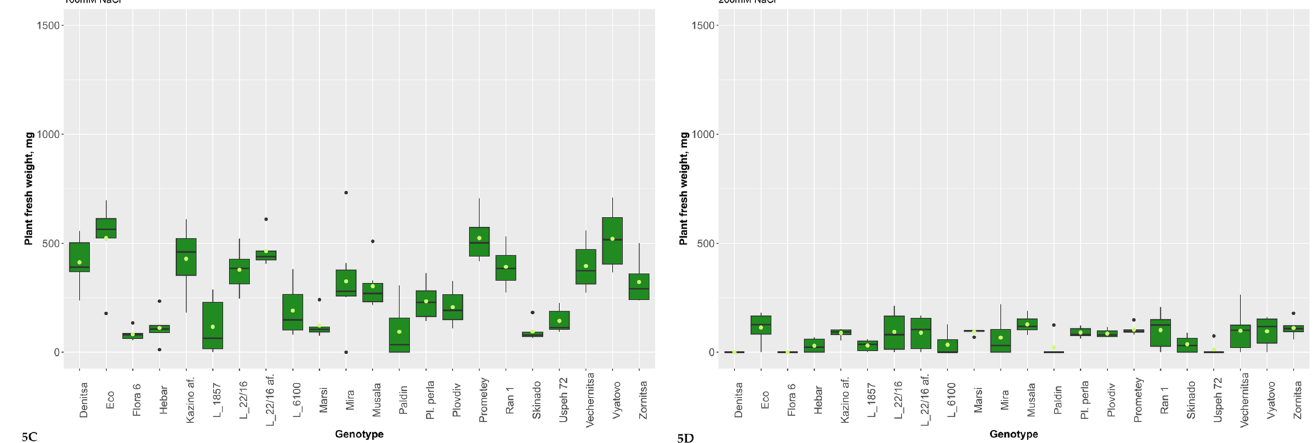
Figure 5. Plant fresh weight (mg) of 22 garden pea genotypes as influenced by the concentration of NaCl in nutrient media in vitro after 14 days of cultivation. ( A ) 0 mM NaCl; ( B ) 50 mM NaCl; ( C ) 100 mM NaCl; ( D ) 200 mM NaCl.